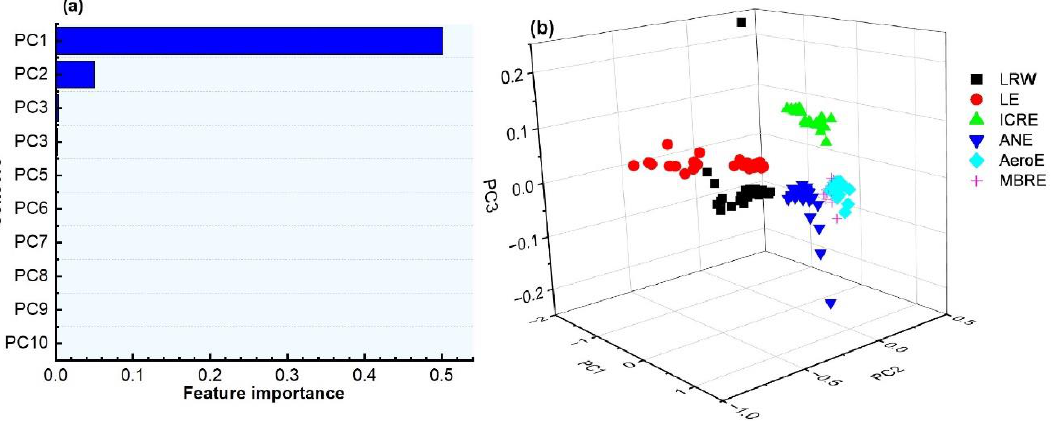
Figure 4. EN data reduction based on PCA: ( a ) PCs ordered according the eigenvalues, ( b ) sample distributions based on the first three PCs.